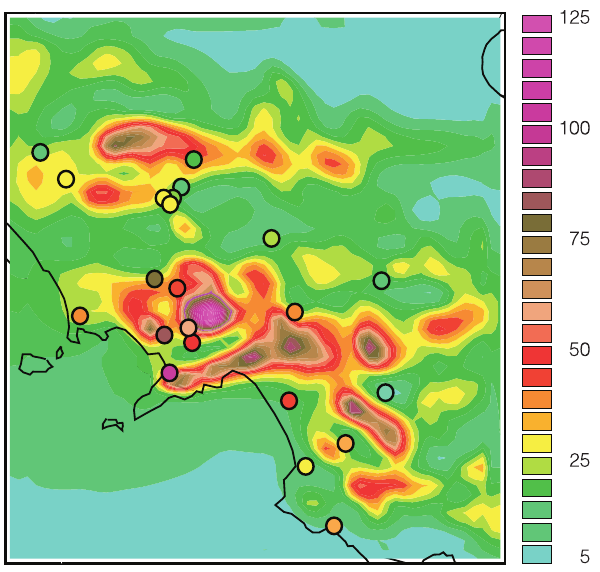
Fig. 6. 24 h accumulated precipitation (mm) ending at 0000UTC 5th May both predicted on domain 3 using three domains two way nested and observed at a few stations (colored circles). The circles are fi lled with the color corresponding to the scale shown on the